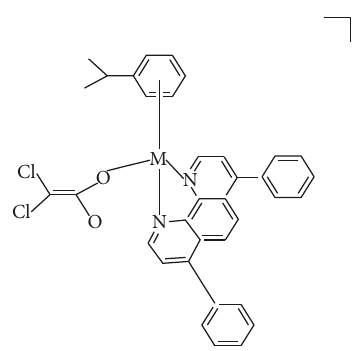
Figure 4: Synthesized half-sandwich Os(II) complex ([ M ( s 6 -ocym) (bphen) (dca)]PF 6 ).